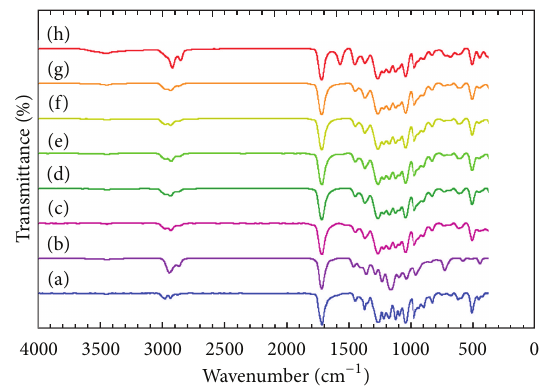
Figure 3: FTIR spectra of (a) pure PHB, (b) pure PCL, and (c) 80PHB/20PCLblendandPHB/PCL/stearateMg-AlLDHnanocom- positewith(d)0.25,(e)0.5,(f)1,(g)1.5,and(h)2wt%stearateMg-Al LDH